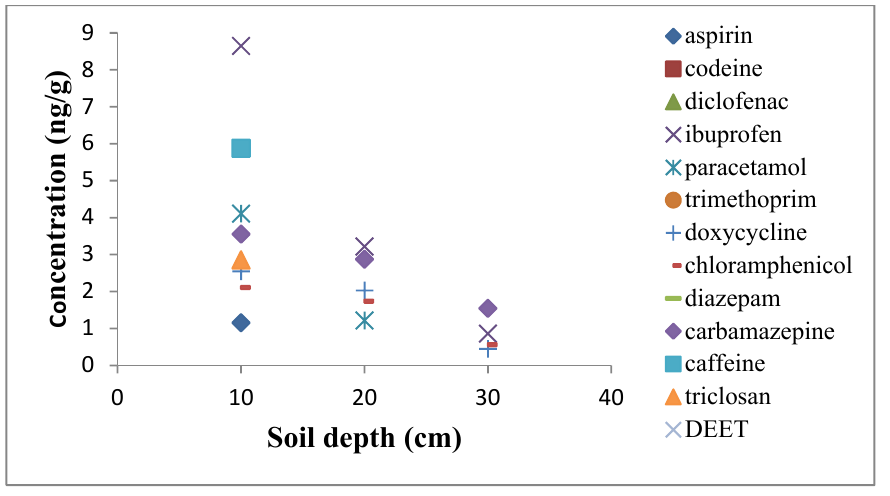
Figure 4. Concentration profiles of the examined compounds in soil (golf–course irrigated with effluents of the WWTP).